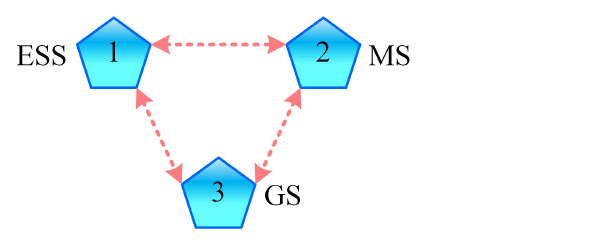
Figure 1. Microgrid testbench.